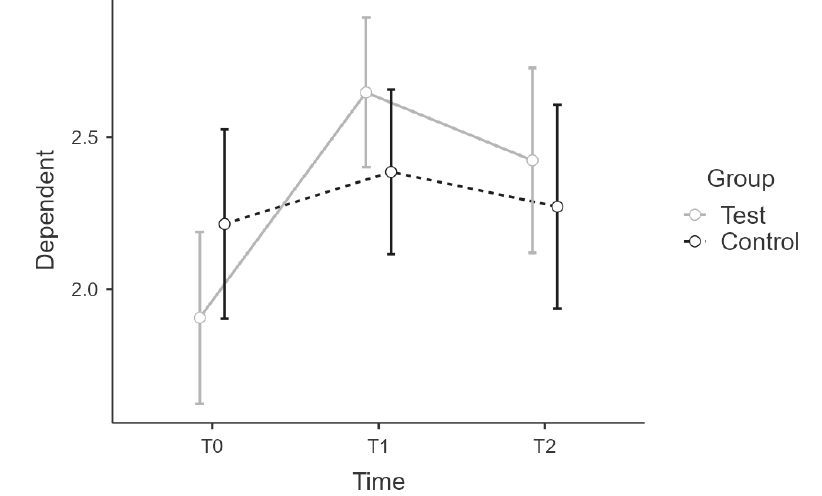
Figure 6. Estimated marginal means for PSQ DEM score.